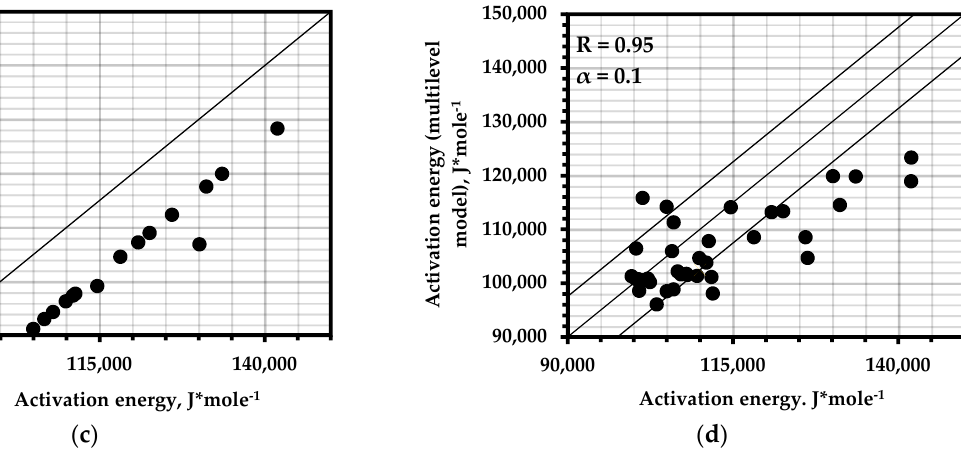
Figure 6. Correlation of the results of the calculation of the activation energy of fracture using a multilevel model of the AE pulse flow compared with: ( a )—data of fatigue curves of alloys; ( b )—Grabar’s formula for fatigue curves; ( c )—results of static tests of samples; ( d )—Moghanlou’s formula for fatigue tests.